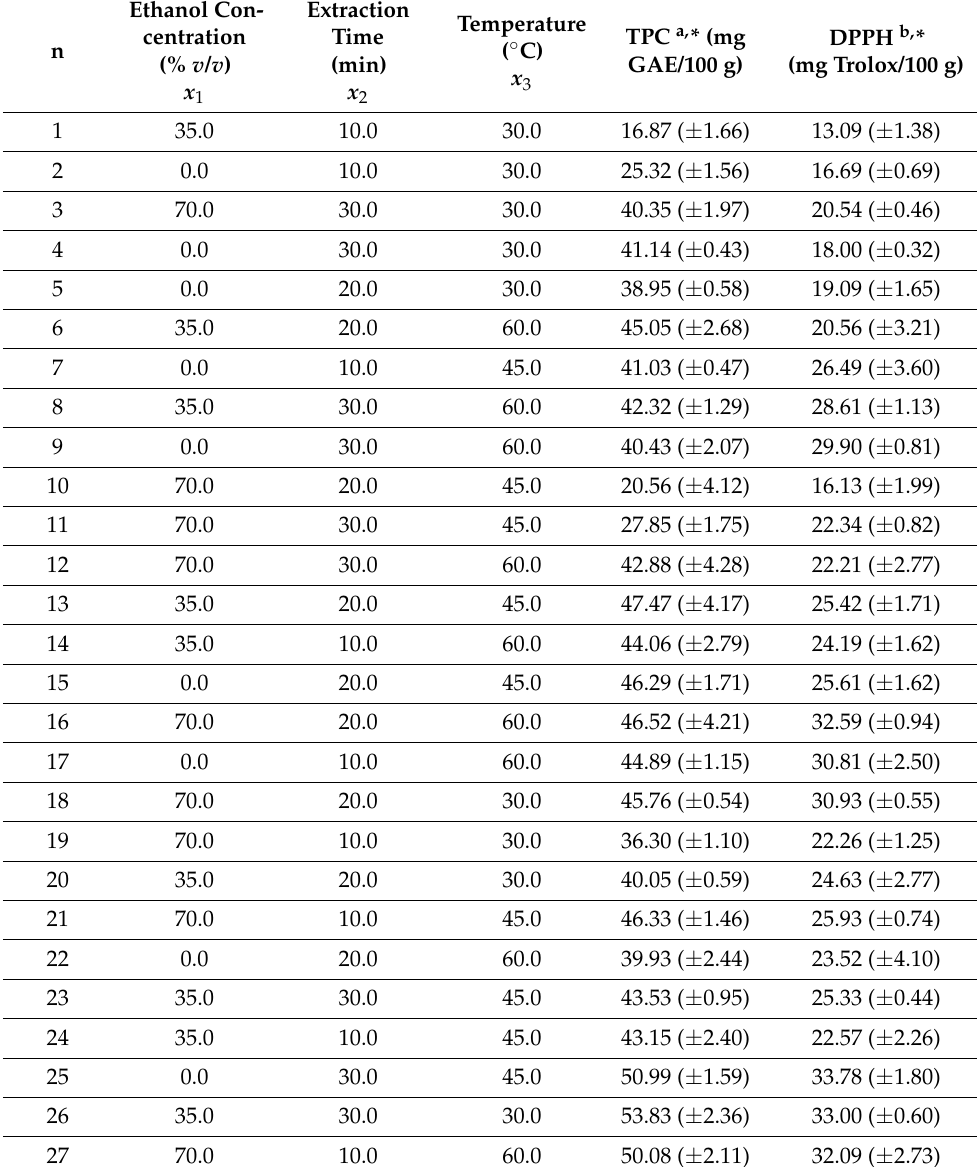
Table 1. Complete factorial design (3 3 ) employed to obtain the extracts from Welsh onion leaves by ultrasound-assisted extraction and experimental